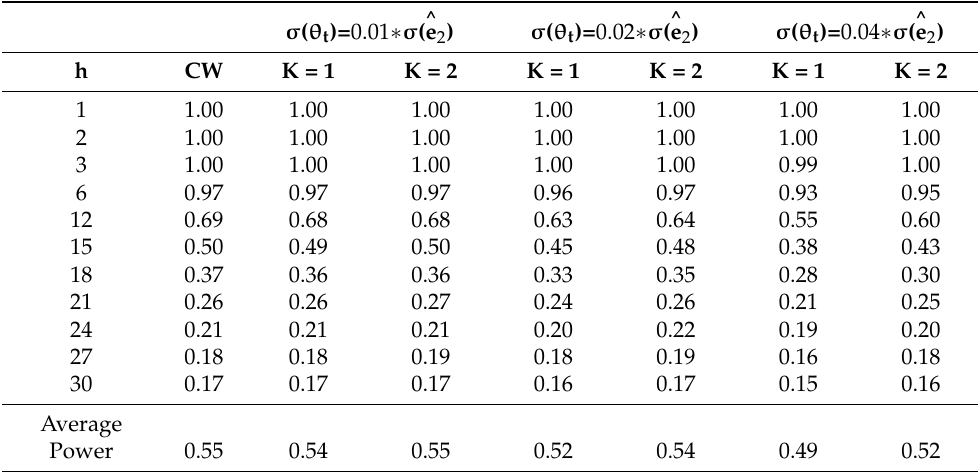
Table 7. Power comparisons between CW and WCW tests with nominal size of 10%, considering DGP1 and a large sample.